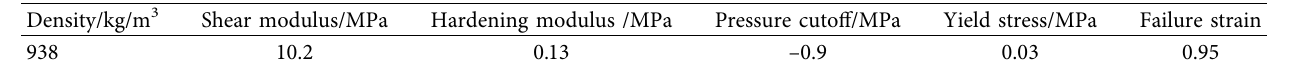
Table 12: Parameters of elastic-plastic hydrodynamic